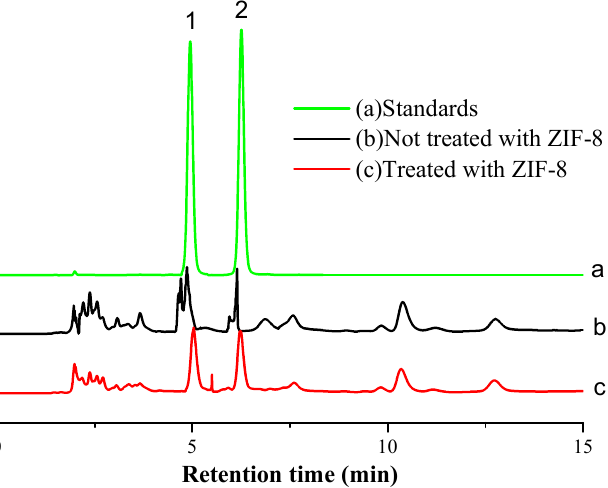
Figure 5. Chromatogram of standards and samples (1. Pyridoxal; 2. Pyridoxine). UPLC conditions: The detector was a fluorescence detector. The excitation wavelength was 280 nm; the emission wavelength was 400 nm. The separation was carried out on a C18 column. The column temperature was 30 ◦ C. The mobile phase consisted of methanol (A) and 0.3% formic acid solution (B). The gradient program was as follows: 0 min: 95% B; 8.0 min: 83% B; 8.1 min: 10% B; 10 min: 10% B; and 10.1 min: 95% B. The total run duration was 15.0 min. The flow rate was 1.0 mL/min and the injection volume was 10 μL.